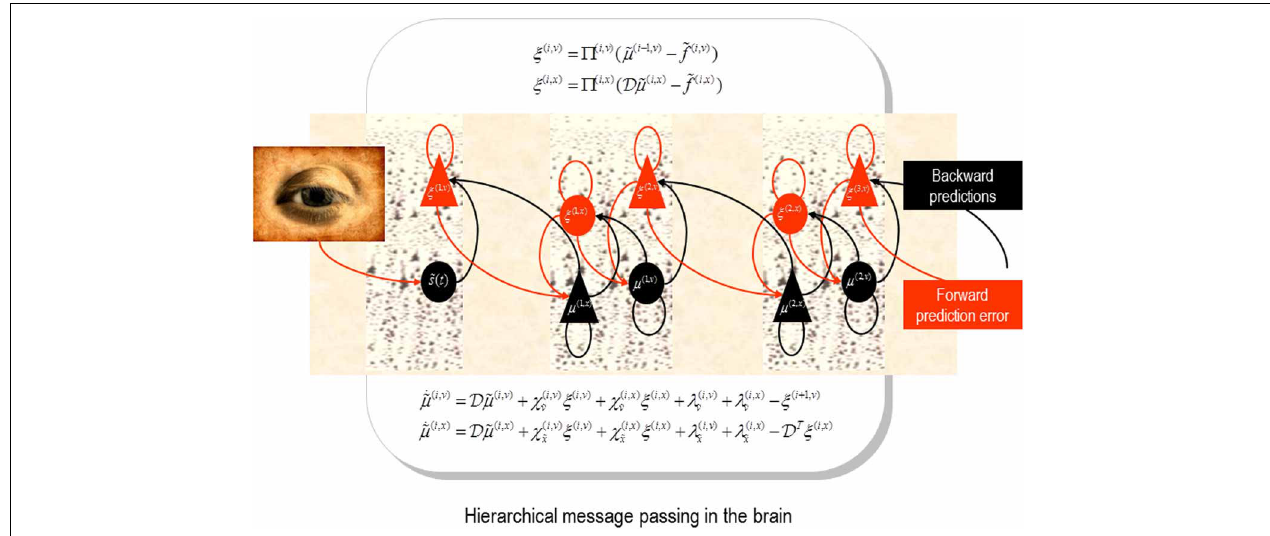
FIGURE 1 | Schematic detailing the neuronal architecture that might implement generalized predictive coding. This shows the speculative cells of origin of forward driving connections that convey prediction error from a lower area to a higher area and the backward connections that construct predictions (Mumford, 1992; Friston et al., 2006). These predictions try to explain away prediction error in lower levels. In this scheme, the sources of